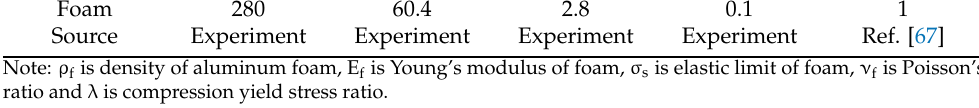
Table 6. Material properties for aluminum foam.